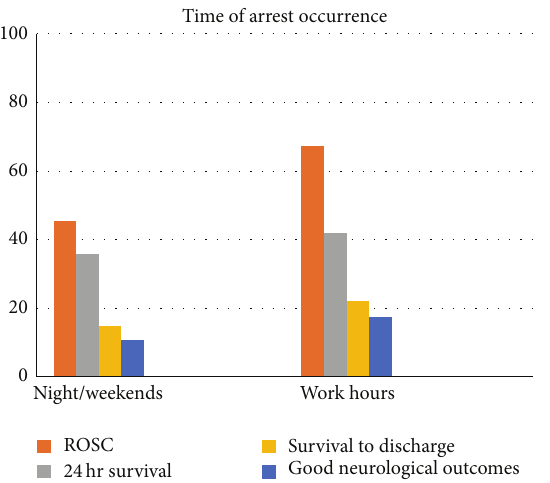
Figure 2: Time of cardiac arrest occurrence.